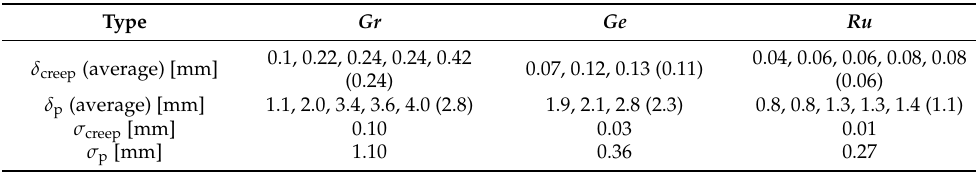
Table 4. Creep and plastic displacements.